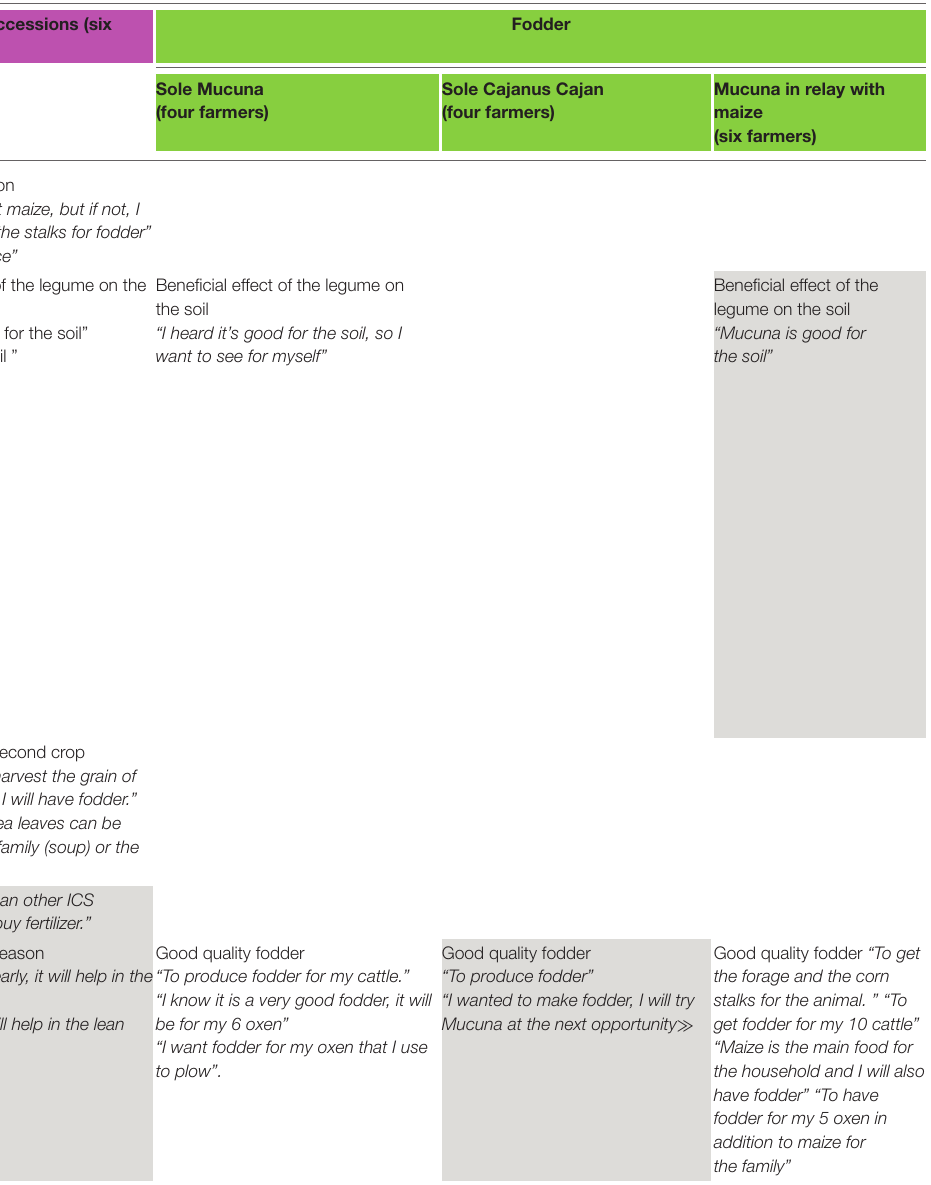
TABLE 3 | For each type of ICS implemented by the farmers (in the columns), the selection criteria they declared in response to the open-ended question “Why did you choose this cropping system?” are presented according to the corresponding type of criteria (in the